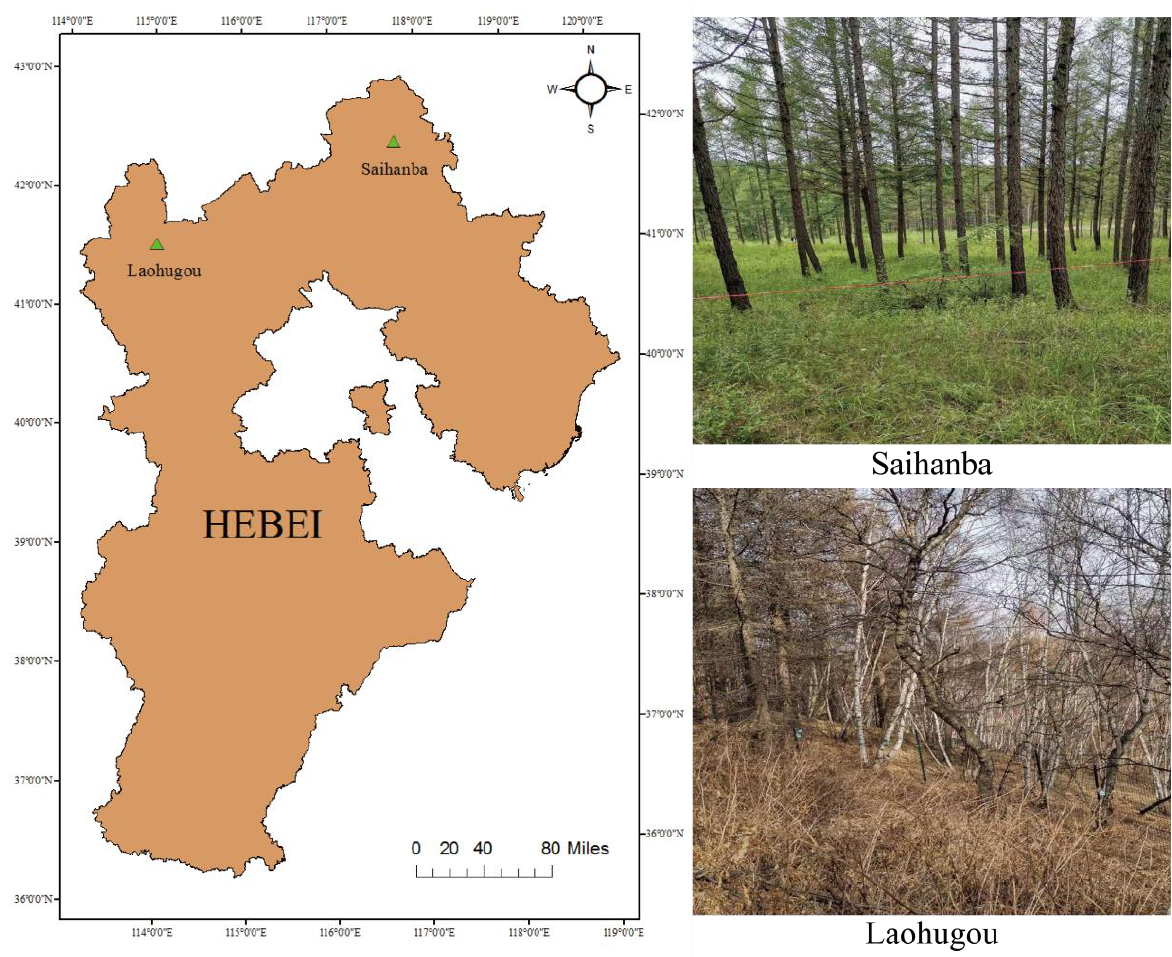
Figure 1. The location map of the study